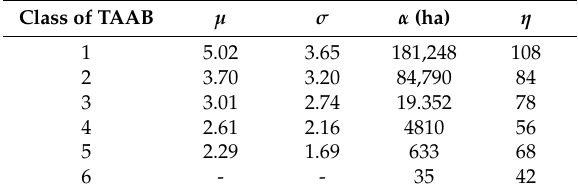
Table 2. Parameters of fire size distribution and annual ignition number for individual fires that occurred in each of the six classes of total annual burned (TAAB), including mean ( µ ) and standard deviation ( σ ) of individual fire size lognormal distribution, maximum individual fire size ( α ), and annual number of individual fires ( η ). Values are in hectares as that unit is employed in LANDIS-II. Class of TAAB µ σ α (ha) η 1